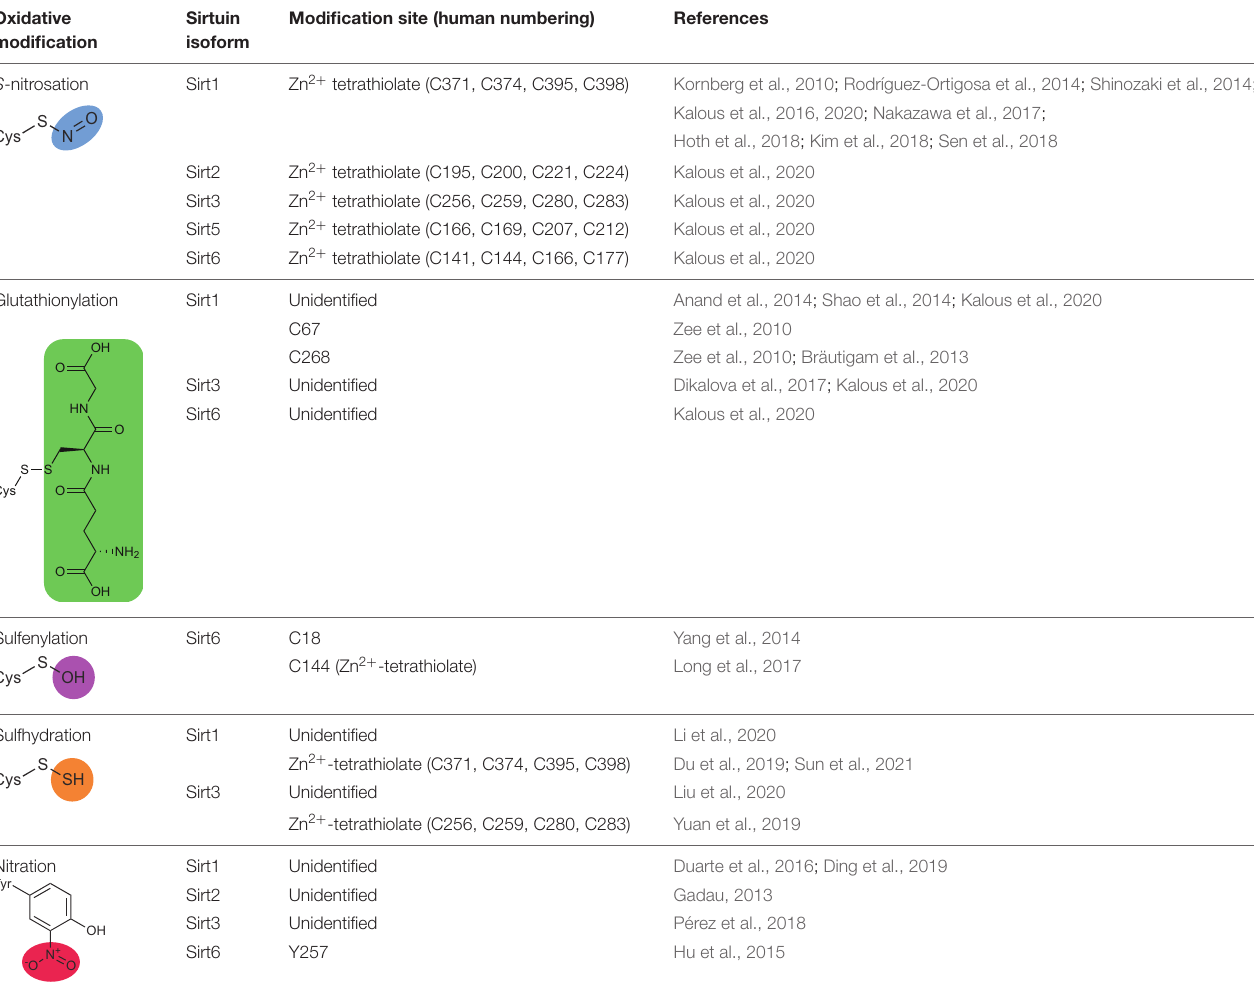
TABLE 3 | Oxidative modifications of human sirtuins, sites of modification, and associated references. Oxidative Sirtuin Modification site (human modification isoform